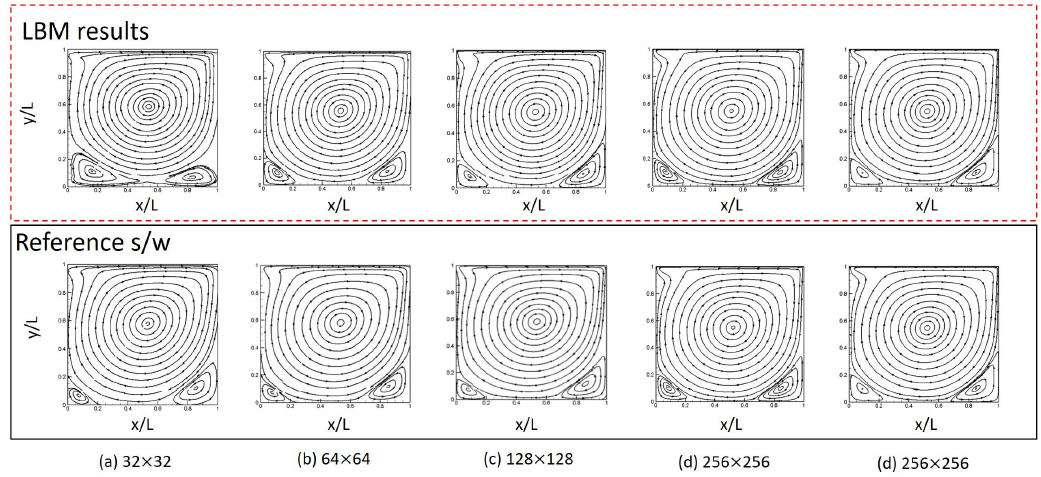
Figure 5. Mesh dependence check in terms of the size of the grid under the Re = 2000. The results were compared with those obtained using the commercial software ANSYS Fluent.